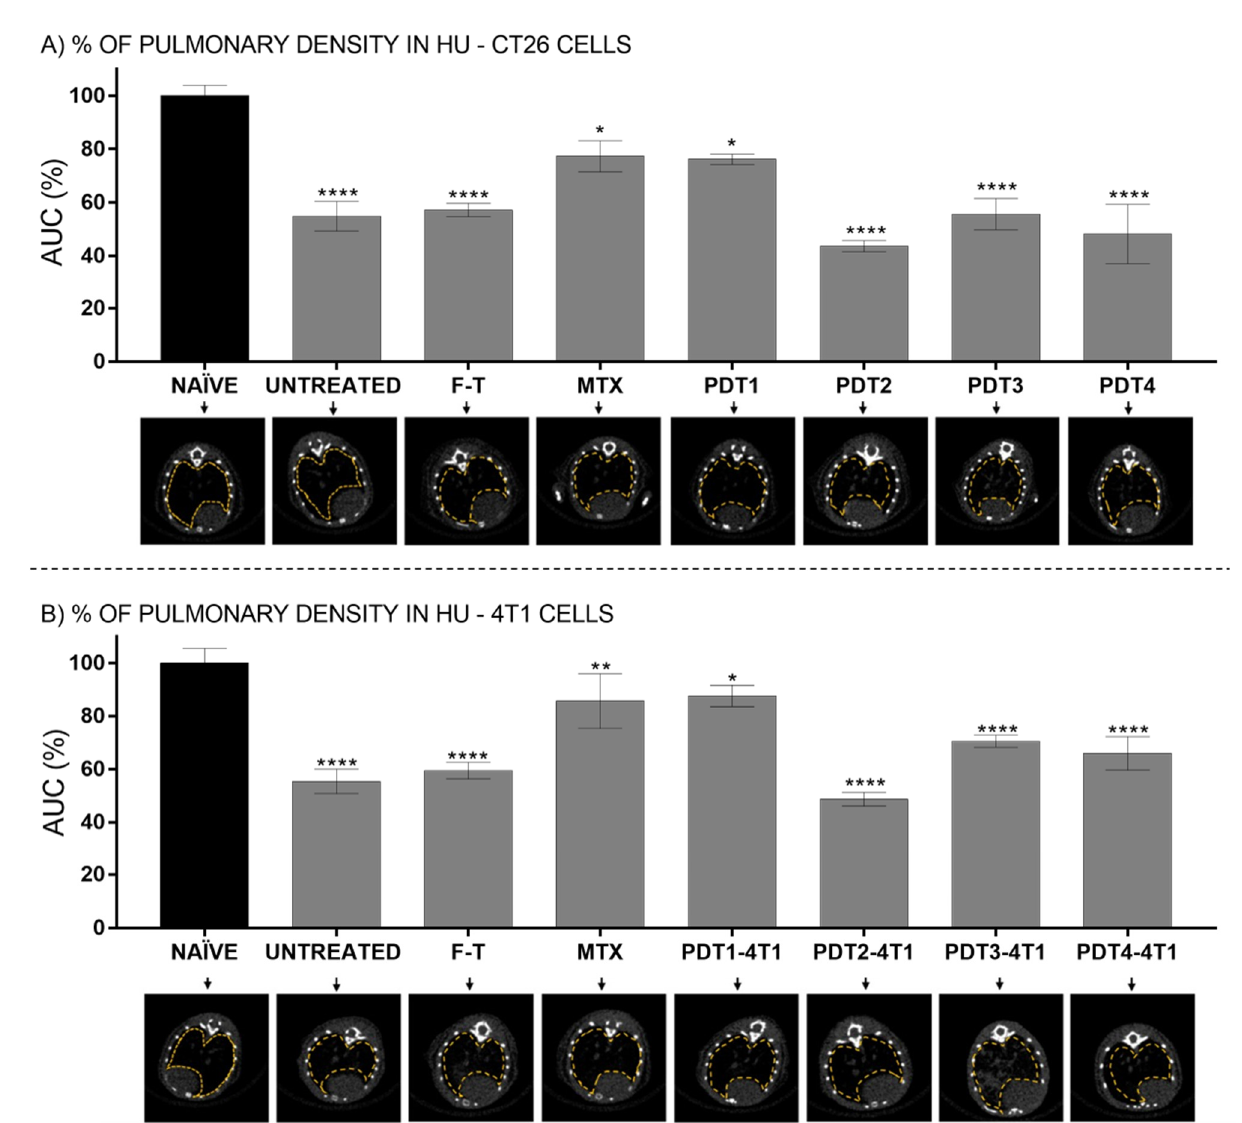
Figure 4. In vivo CT quantification of lung density area using HU values. ( A ) Lung density of animals subjected to vaccination with CT26 cells pretreated with PBS (untreated); F-T; MTX and different PDT protocols. ( B ) Lung density of animals subjected to vaccination with 4T1 cells pretreated with PBS (untreated); F-T; MTX and different PDT protocols. Group of healthy animals (naïve) were used as the control for evaluation of lung density (100%-black bars). Lung 2D representative CT-transverse of the animals references the groups: CT26 cells—PDT protocols: PDT1 = 12.2 nM and 25 J/cm²; PDT2 = 31.5 nM and 25 J/cm²; PDT3 = 12.2 nM and 67 J/cm²; and PDT4 = 31.5 nM and 67 J/cm². 4T1 cells—PDT protocols: PDT1 = 9.01 nM and 25 J/cm²; PDT2 = 19.4 nM and 25 J/cm²; PDT3 = 9.01 nM and 67 J/cm²; and PDT4 = 19.4 nM and 67 J/cm². MTX (mitoxantrone); F-T (three cycles of freeze- thawing); PBS: phosphate buffered saline. Superscript *, ** and **** means p < 0.05, p < 0.01 and p < 0.001, respectively. For all data, n = 6 mice, mean ± SEM.